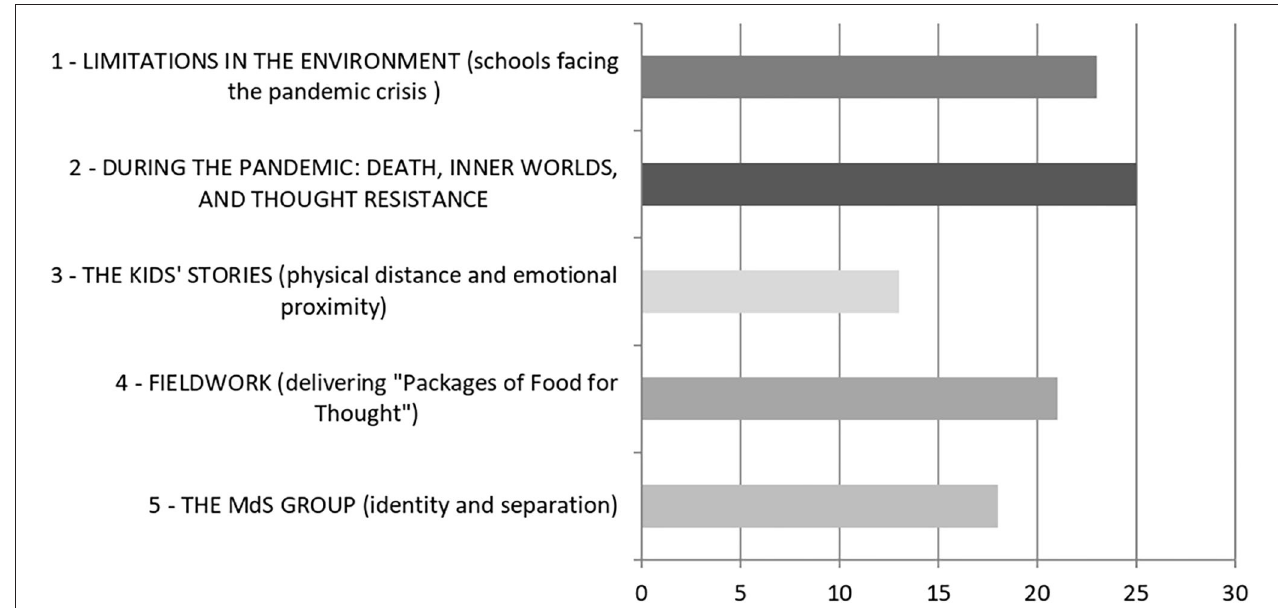
FIGURE 2 | Early pandemic Corpus (T2): % of ECUs grouped in each